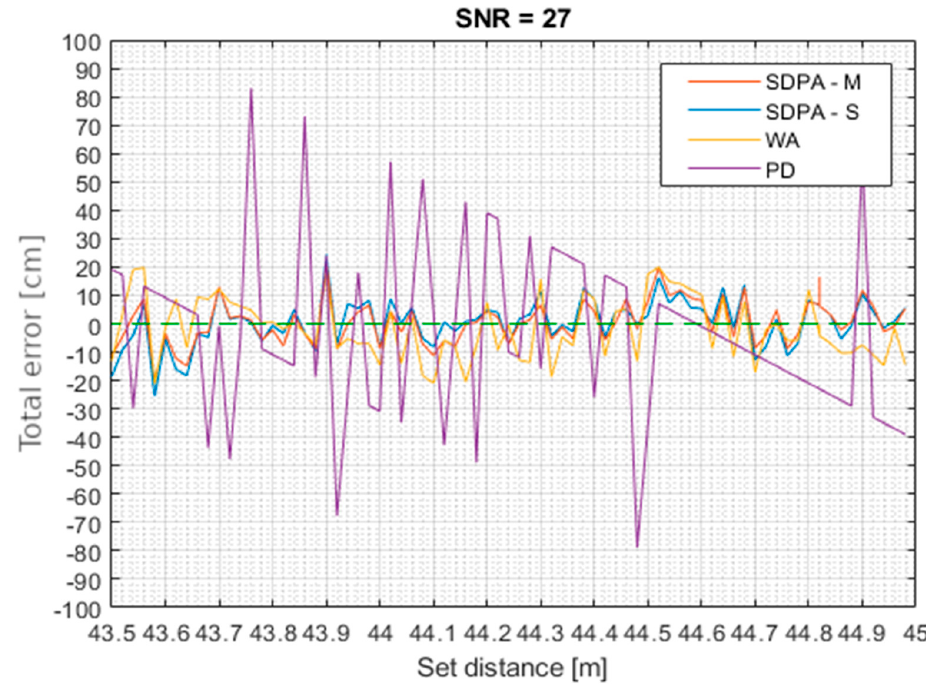
Figure 17. Trial 4. Total error of measurements as a function of set distance for SNR = 27.